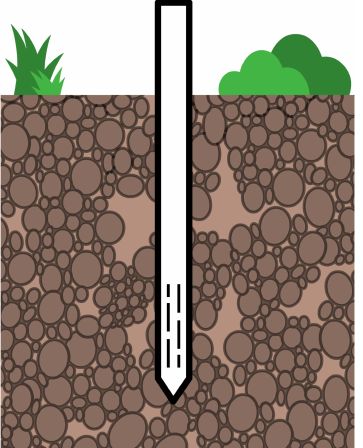
Figure 4. Conceptual diagram of a mini-piezometer (Coluccio, 2018).